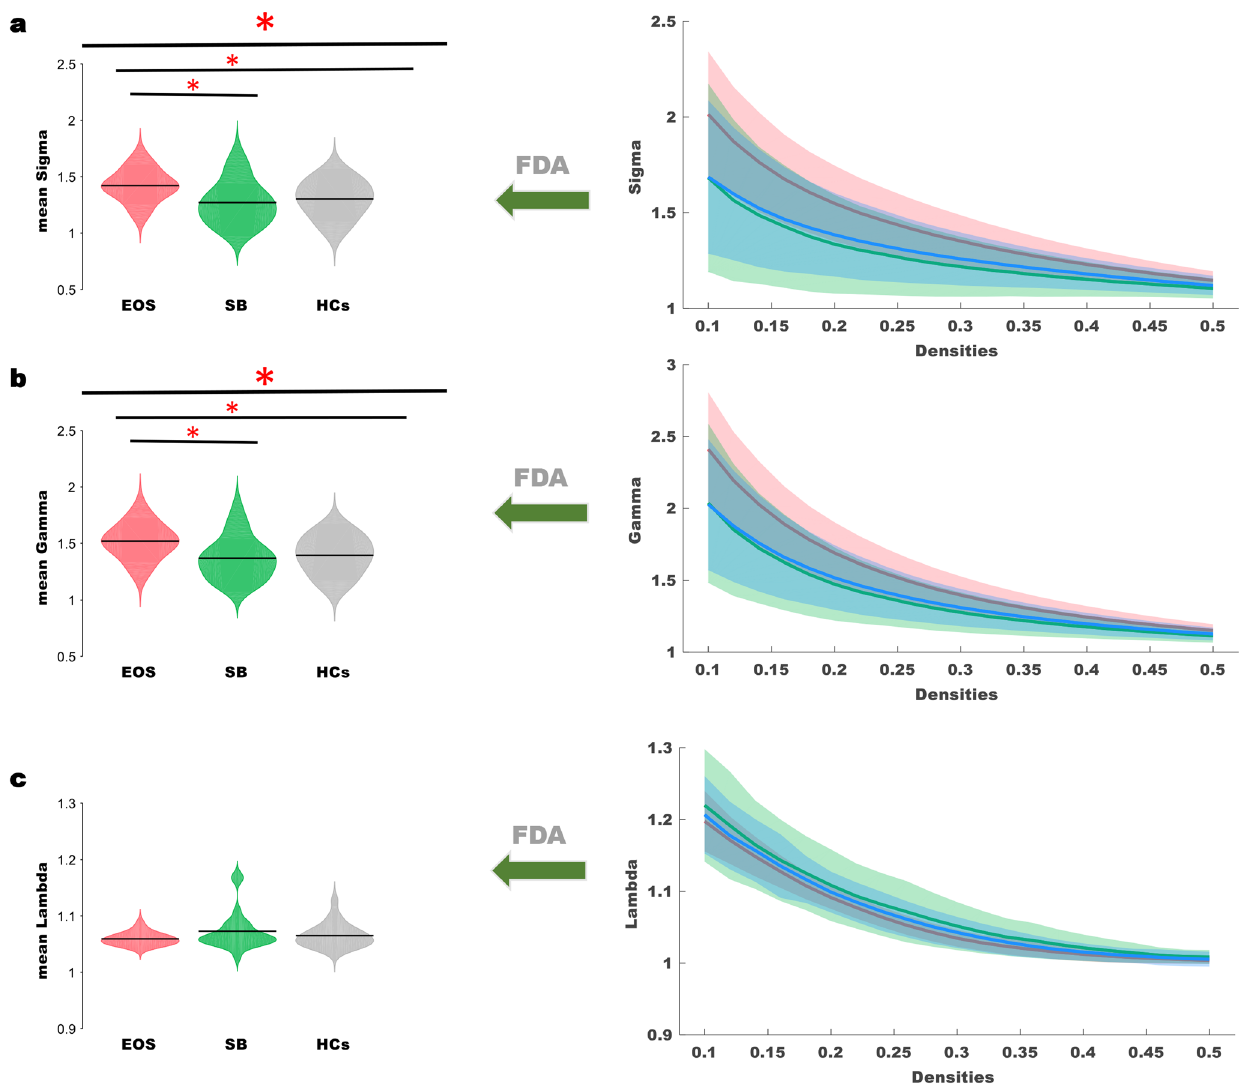
Fig. 1 Global properties of the whole-brain functional connectome calculated on Power atlas in three diagnostic groups. The range of densities is 0.1:0.02:0.5, and symbol “ * ” represents p < 0.05. a Comparison of mean sigma across densities among three groups; b comparison of mean gamma across densities between three groups; c comparison of mean lambda across densities among three groups.